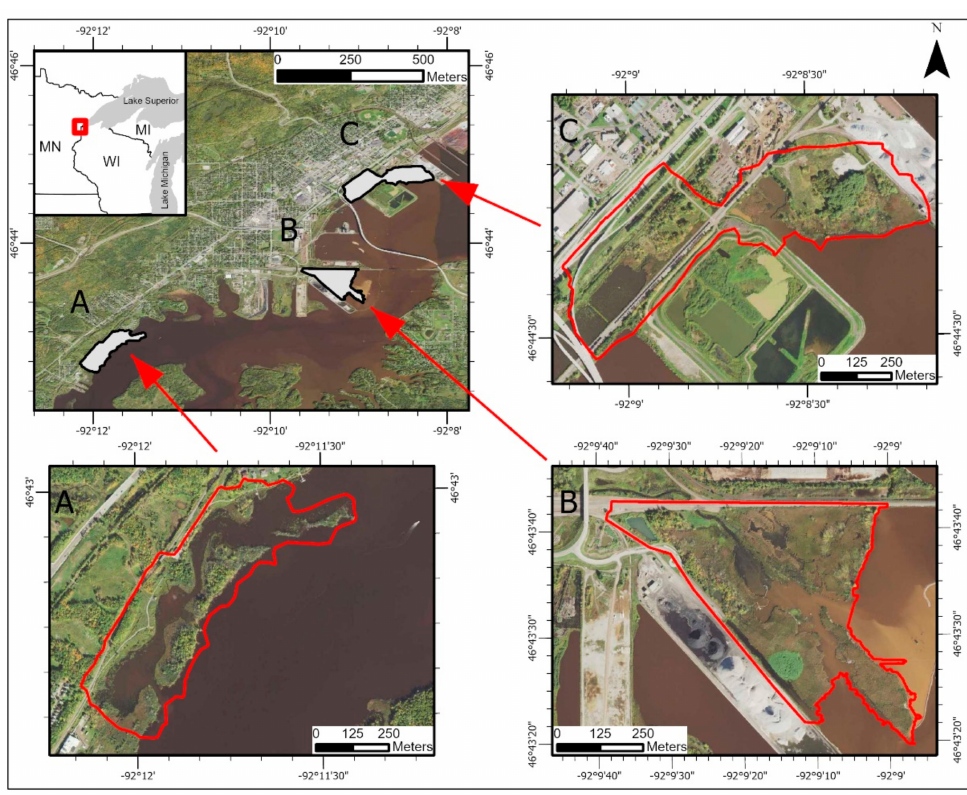
Figure 1. Study sites located in the St. Louis River Estuary in Duluth, Minnesota, USA: ( A ) Tallas Island, ( B ) Grassy Point Park, and ( C ) Hallett Dock.